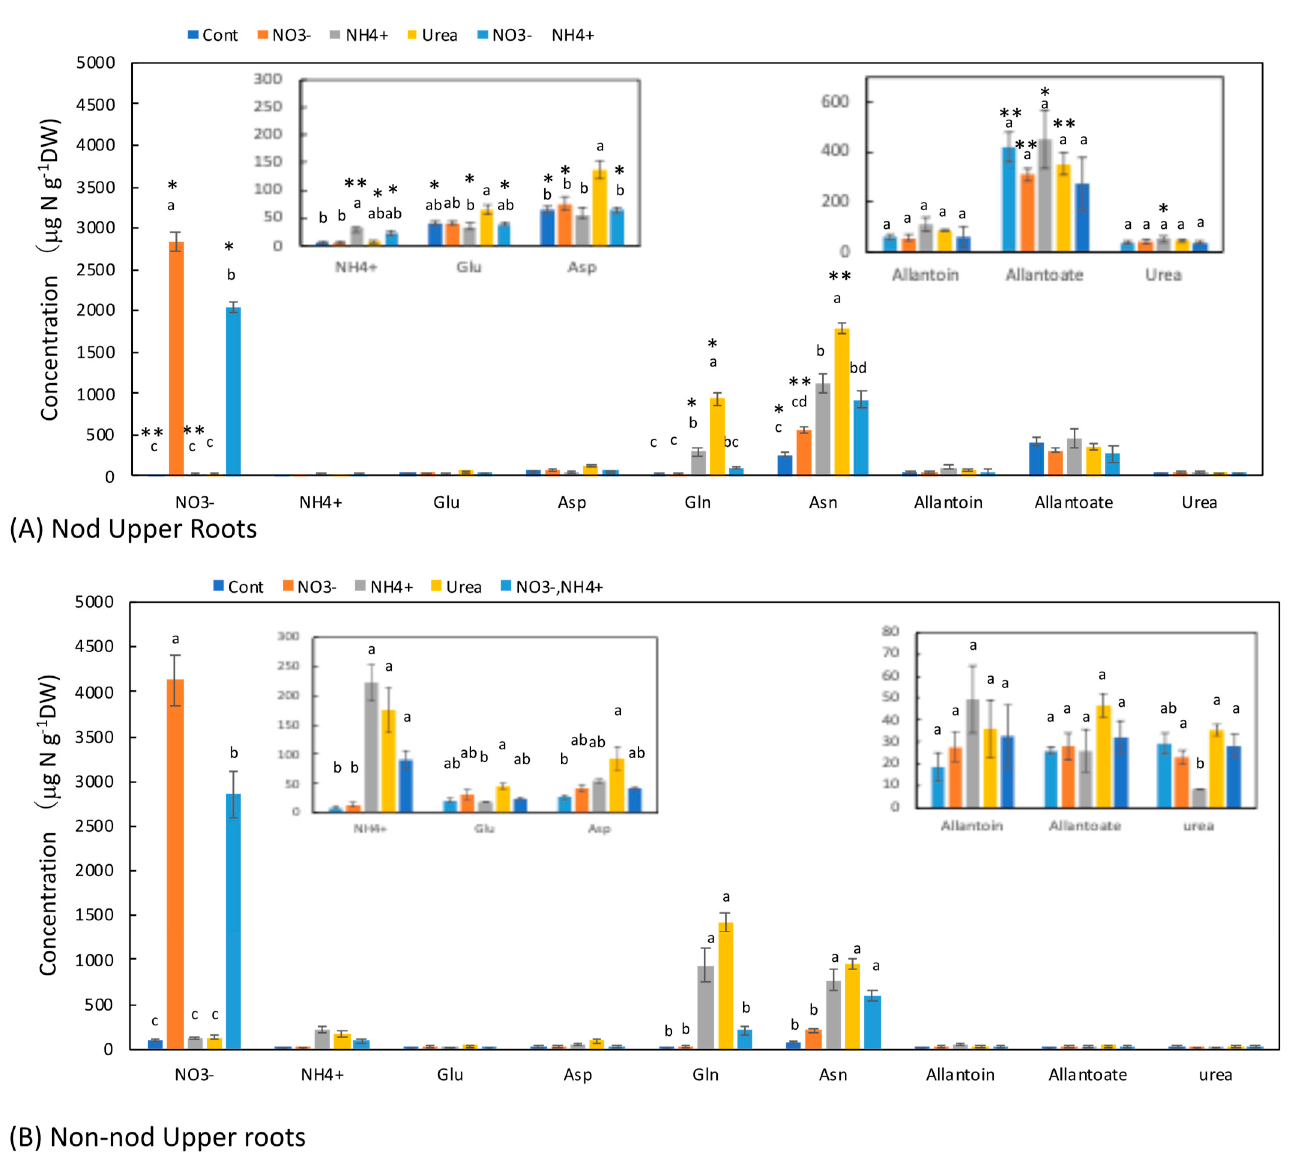
Figure 5. Comparison of the concentrations of the principal N metabolites in the upper roots of the Nod and Non-nod soybean plants treated with the various N compounds. The symbols, abbreviations and the explanations of the statistics are the same as in Figure 2.